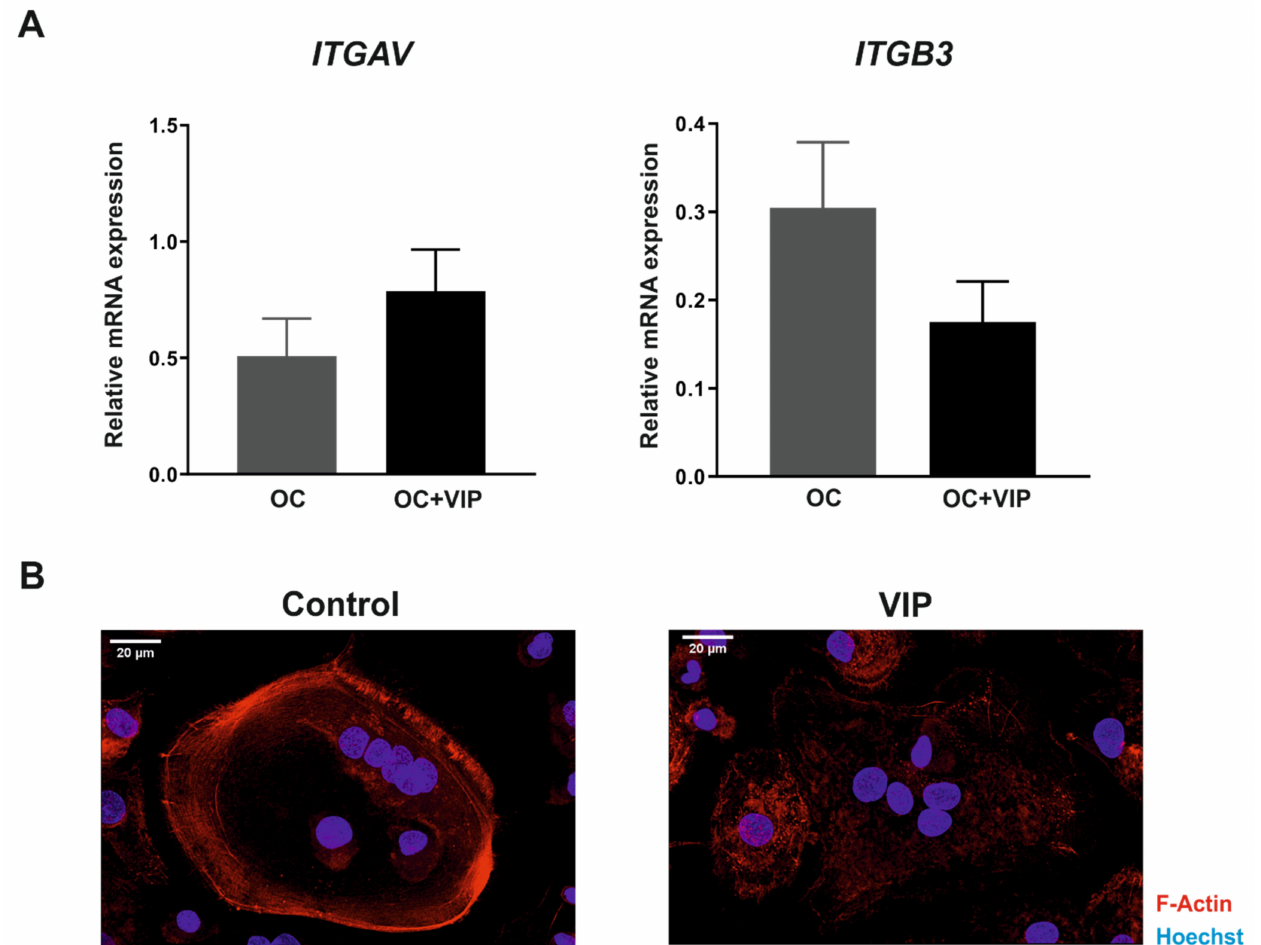
Figure 5. VIP interferes with the formation of the bone resorption lacuna. ( A ) Gene expression of α v β 3 integrin subunits ITGAV and ITGB3 in differentiated osteoclasts in absence (OC) or presence of VIP 10 − 8 M (OC+VIP) was determined by real-time PCR. Results are expressed as relative mRNA expression (relative to GAPDH levels). The means ± SEM of triplicate determinations of 6 independent experiments are shown. Mann–Whitney U test was performed. ( B ) Photomicrographs of the effect of VIP on the ring-shaped actin cytoskeleton in differentiating osteoclast. Detection of F-actin was performed using Atto 645N-Phalloidin staining (red), nuclei were counterstained with Hoechst. Florescence was examined on a Leica SP8 LIGHTNING confocal